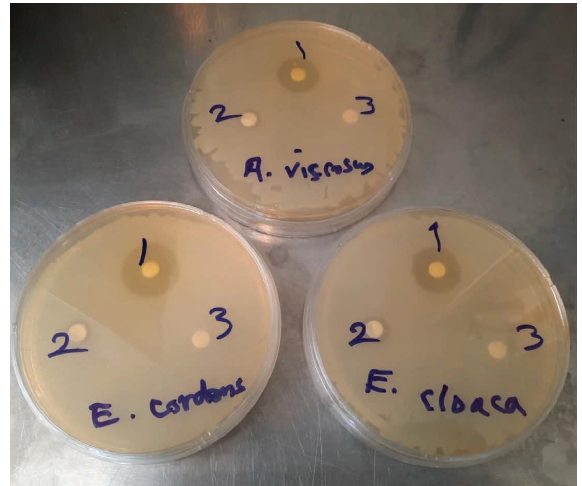
Figure 1: Sample plates containing A. viscosus , E. corrodens , and E. cloaca cultured on Mueller–Hinton agar. Paper discs impreg- nated with (1). chlorhexidine, (2). Tymex, and (3). distilled water (negative